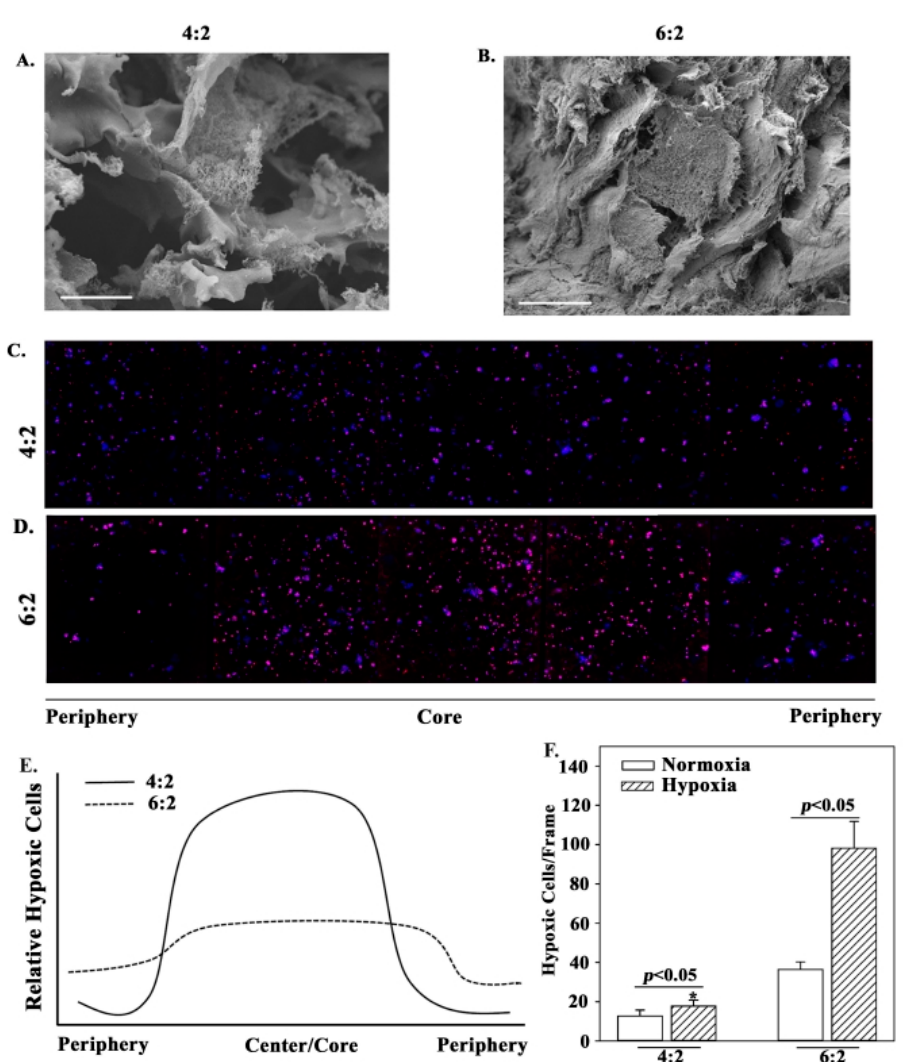
Figure 3. Scaffold ultrastructure and cell hypoxia. The ultrastructure of ( A ) 4:2 and ( B ) 6:2 cell-free scaffolds, by scanning electron microscopy (SEM). Shown are representative images at 2500X magnification. Scale bar: 10 µm. ( C ) Cells in 4:2 ( C ) and 6:2 ( D ) scaffolds were visualized by confocal microscopy for hypoxic cells from periphery to core. The number of hypoxic cells (expressing the Lox1 fluorescent hypoxia probe) in normoxic (open bar) or hypoxic (diagonal-stripped bar) incubation systems. Cells within ( C ) 4:2 and ( D ) 6:2 scaffolds treated with a Lox1 fluorescent hypoxia probe were imaged using confocal microscopy at 10X magnification. The relative differences between ‘C’ and ‘D’ along the structures are diagrammatically presented in ( E ). The number of normoxic and hypoxic cells were counted across 5 frames and the values presented as mean cells±SD ( F ), * p < 0.05 vs. 6:2 hypoxic cells. The images represent three different independent experiments.